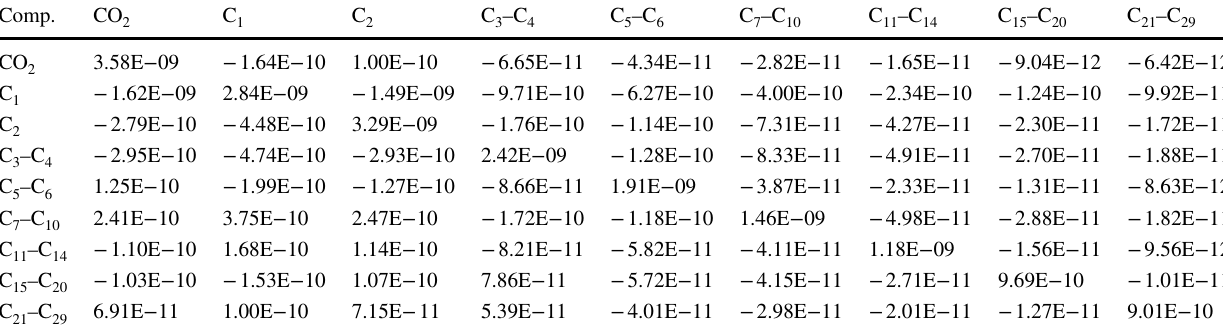
Table 4 Molecular diffusion coefficient estimations, based on Sigmund–Bird correlations (m 2 /s)